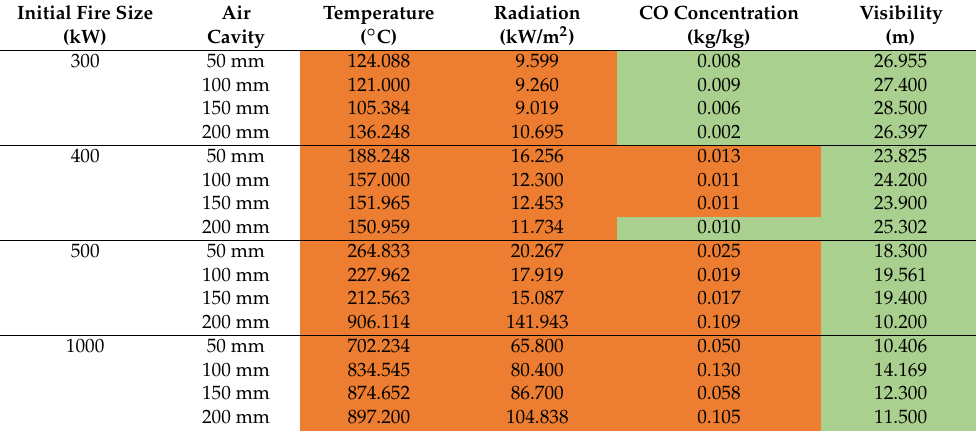
Table 2. Numerical prediction for the tenability parameters at the first floor for cases with variable initial fire size and air gap between insulation layer and external cladding. (parameters above the untenable criteria are highlighted in orange and those below the criteria are highlighted in green).